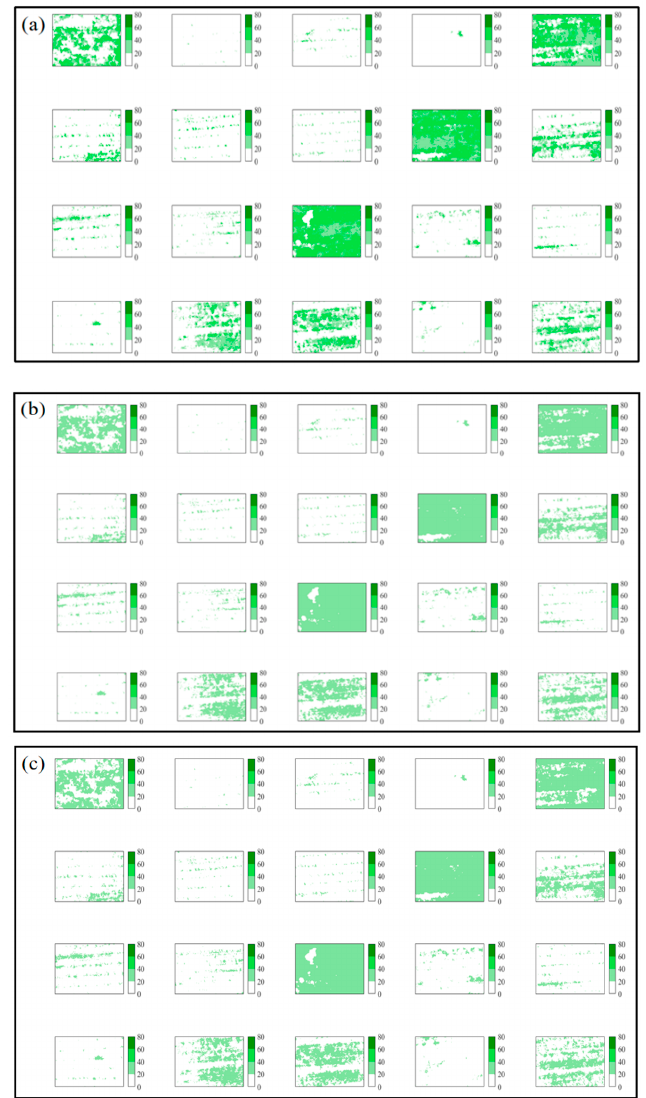
Figure A4. The predicted chlorophyll contents values using BP, SVM, and RF models using images acquired on 8 July 2019. ( a – c ) represented the predicted chlorophyll contents using BP, SVM, and RF, respectively.